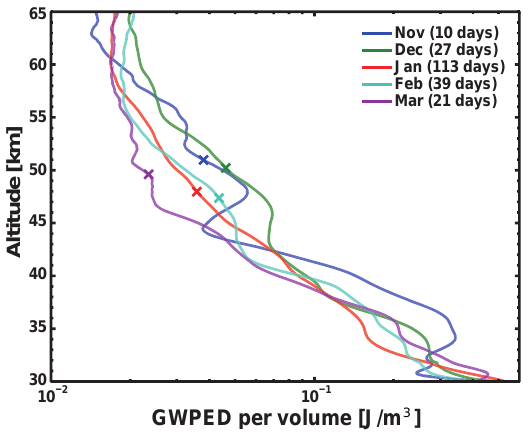
Figure 3. Mean GWPED per volume profiles during different winter months. The crosses mark the respective mean stratopause height. The number of days considered in the monthly mean profile are given in the brackets.